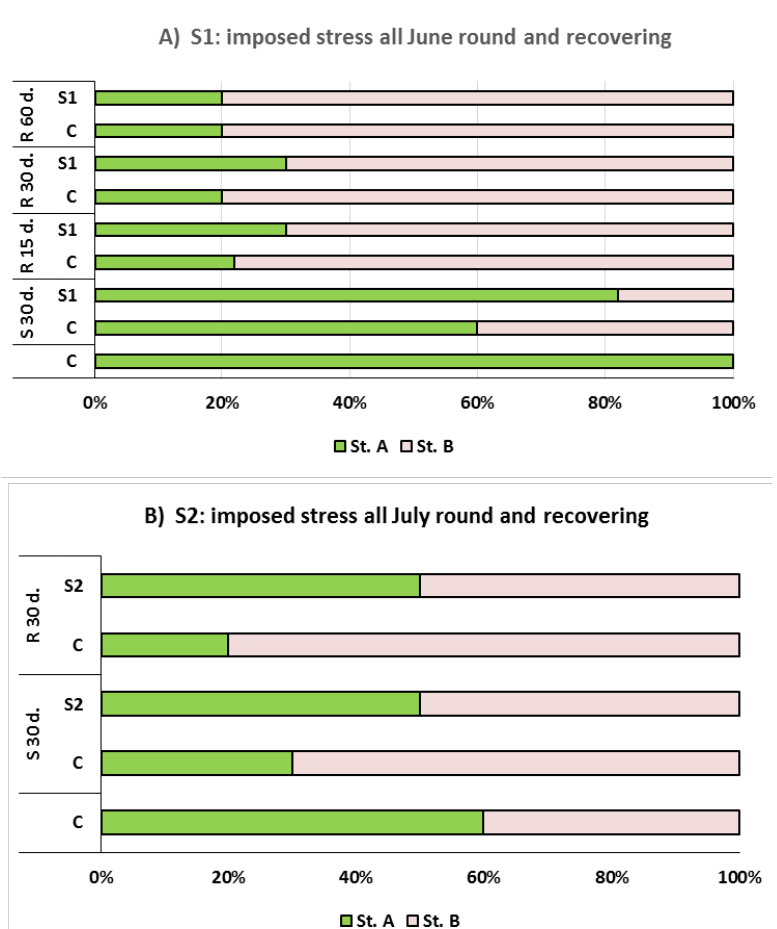
Figure 3. Percentage distribution of floral di ff erentiation stages in ‘Portici’ apricot cultivar subjected to di ff erent periods of summer water stress: ( A ) June (S1), ( B ) July (S2), followed by recovering by re-watering (R) at 15, 30, 60 days. C (control trees). Stage A: undi ff erentiated meristematic apex; Stage B: receptacle primordium arrangement.